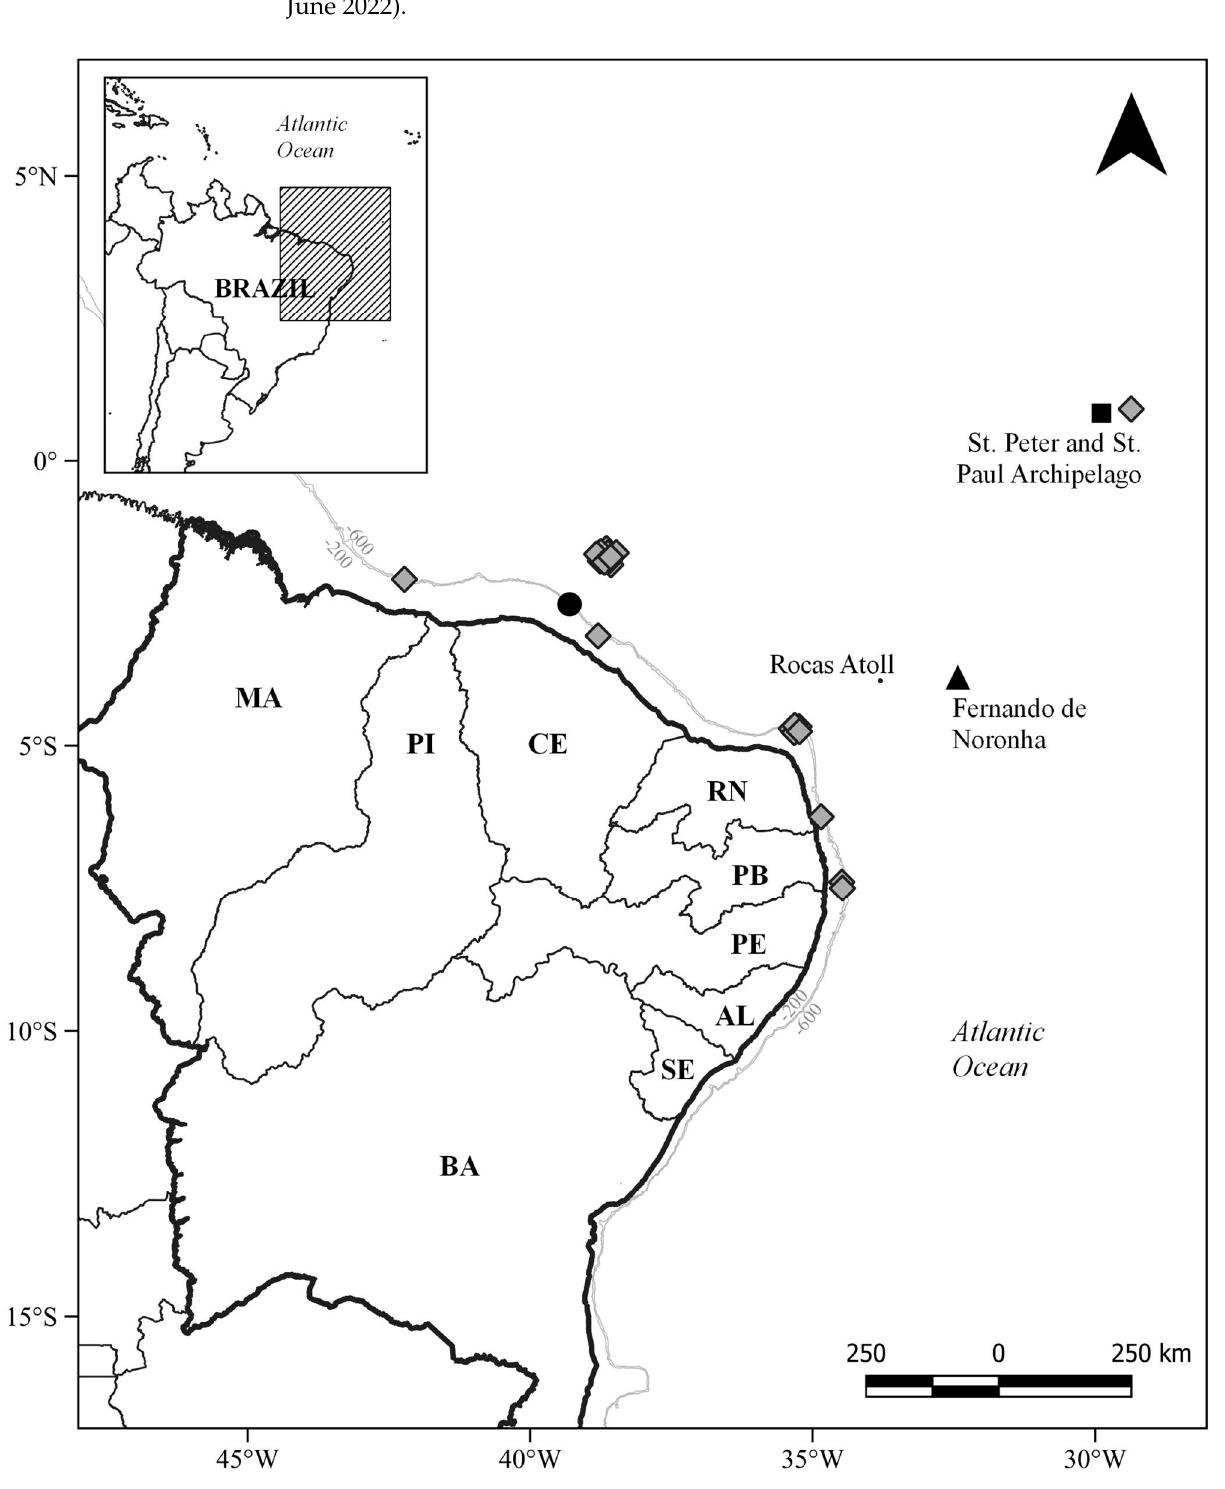
Figure 1. Map depicting previous and additional records for the bluntnose sixgill shark, Hexanchus griseus , from the Tropical Southwestern Atlantic. Gray diamonds indicate new records and black forms indicate previous records. Black triangle: Moreira-Junior (1993); black circle: Santander-Neto et al. (2007); black square: Pinheiro et al. (2020); MA: Maranh ã o; PI: Piau í ; CE: Cear á ; RN: Rio Grande do Norte; PB: Para í ba; PE: Pernambuco; AL: Alagoas; SE: Sergipe; BA: